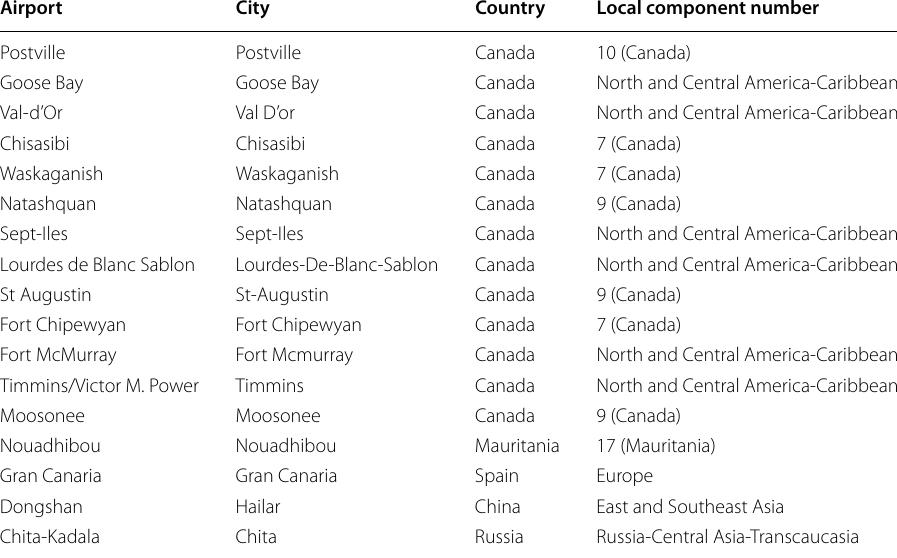
The Local component number corresponds to the number in Fig. 10